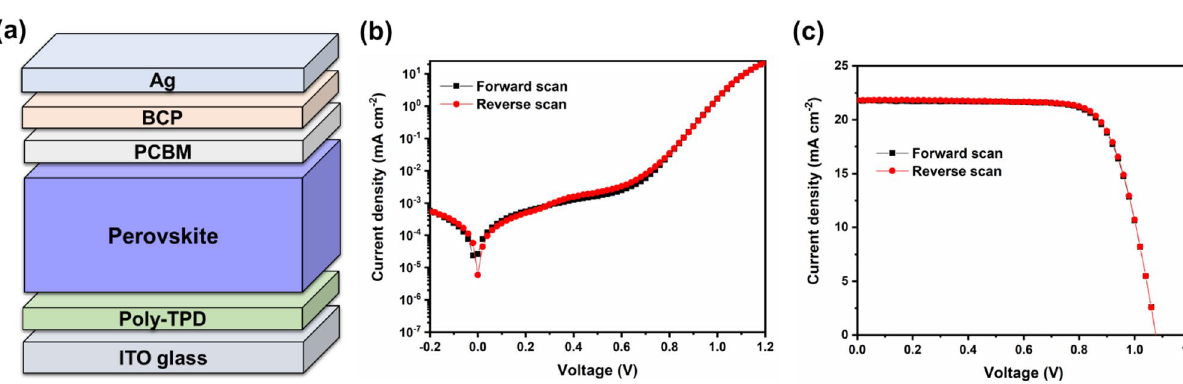
Figure 6. Inverted PSCs based on the slot-die perovskite film: ( a ) schematic device configuration; ( b ) J –V curves in the dark; and ( c ) J –V curves at one-sun illumination. Note : the J –V curves represent the behaviour of a champion